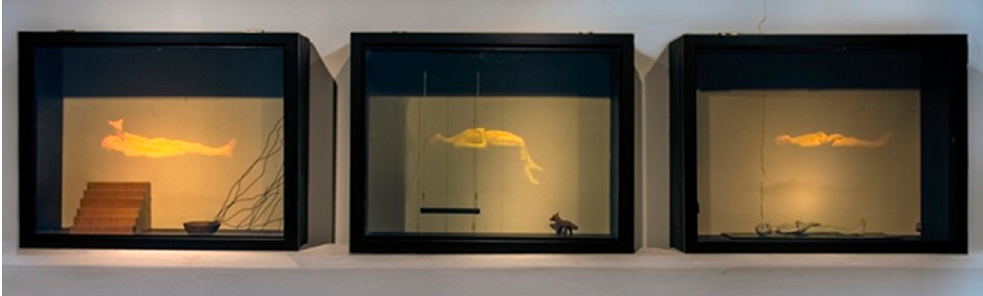
Figure 6. Transitional States (2009). Three holograms, each box 43 cm × 33 cm × 12 cm.